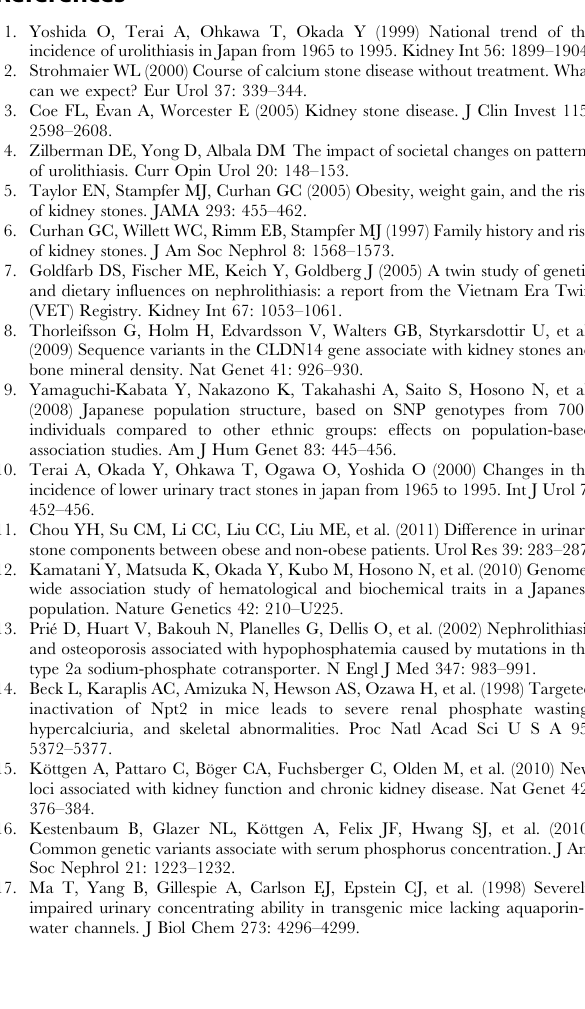
Table S9 Association of rs2835349 with nephrolithiasis in the all stage and combined analysis. Table S10 Multiple logistic regression analysis for risk of nephrolithiasis. Table S11 a) SNPs that compose the weighted genetic risk score and weights assigned to each marker. b) wGRS scores and odd ratios of nephrolithiasis by wGRS groups. Table S12 Sequences of